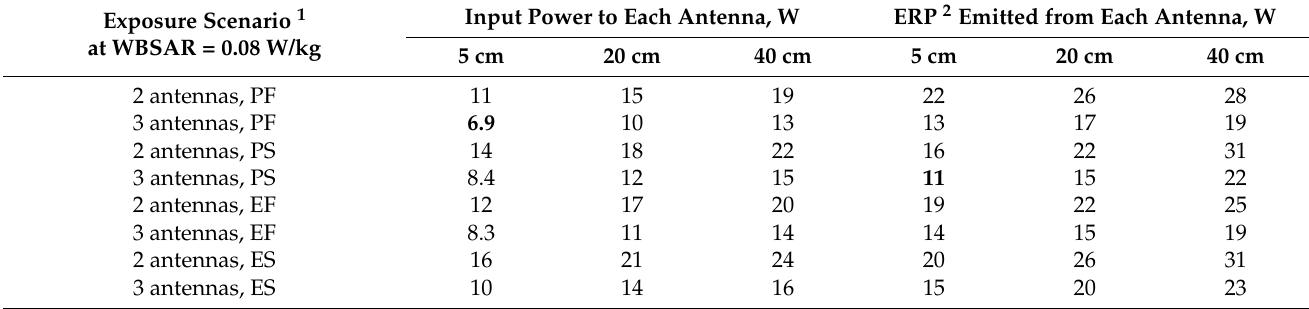
Table 3. The level of EMF emissions from UHF I-RFID readers at 866 MHz, causing WBSAR values in the human body model Duke equal to the general public limits in the considered exposure scenarios (SAR evaluated as averaged over the entire exposed body).